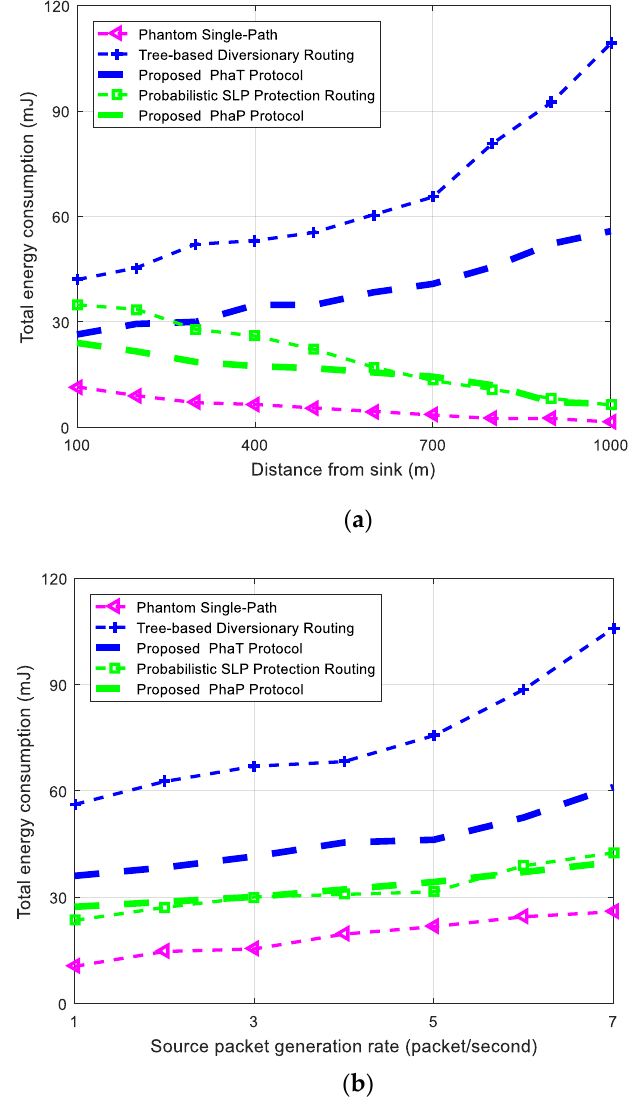
Figure 7. Energy consumption of the protocols. ( a ) Energy consumption against varied source–sink distance. ( b ) Energy consumption against varied source packet generation rate.